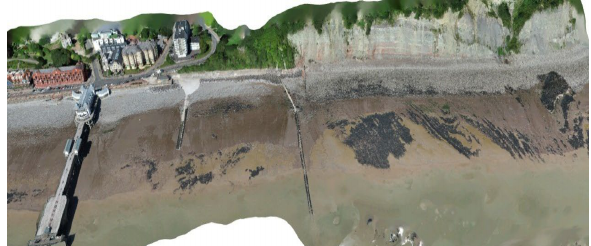
Figure 9a Penarth UAV 3D Photogrammetric Model